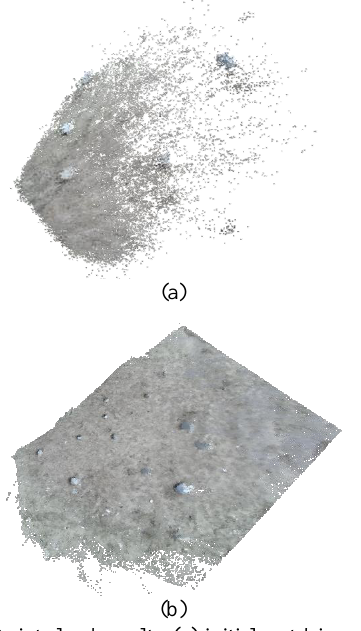
Figure 6. Point cloud results. (a) initial matching results (b) matched points after